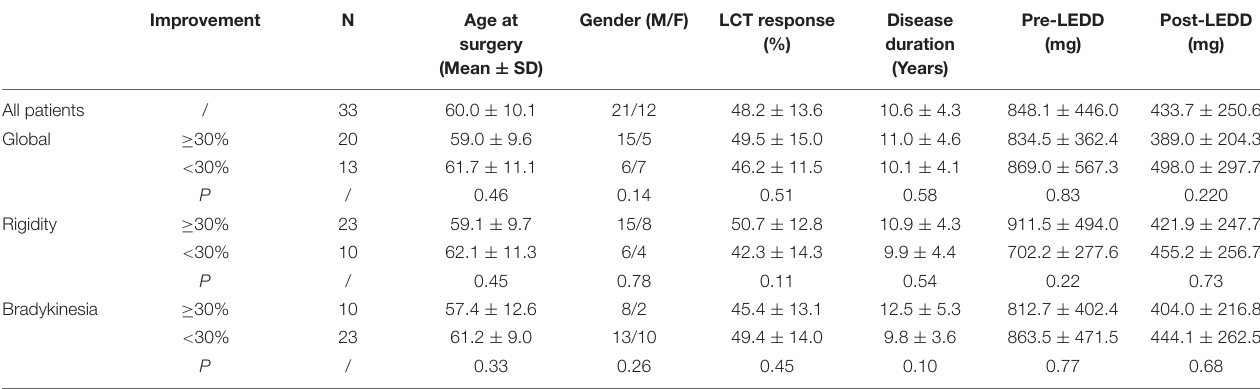
TABLE 1 | Demographic and clinical characteristics of patients with optimal and suboptimal motor outcome.